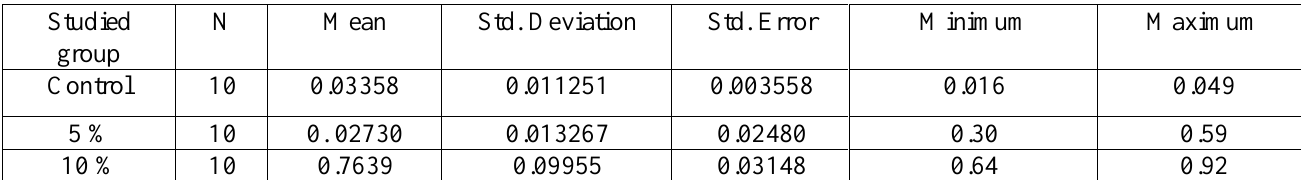
Table 9: Descriptive statistic of water solubility test(mg/cm 2 )